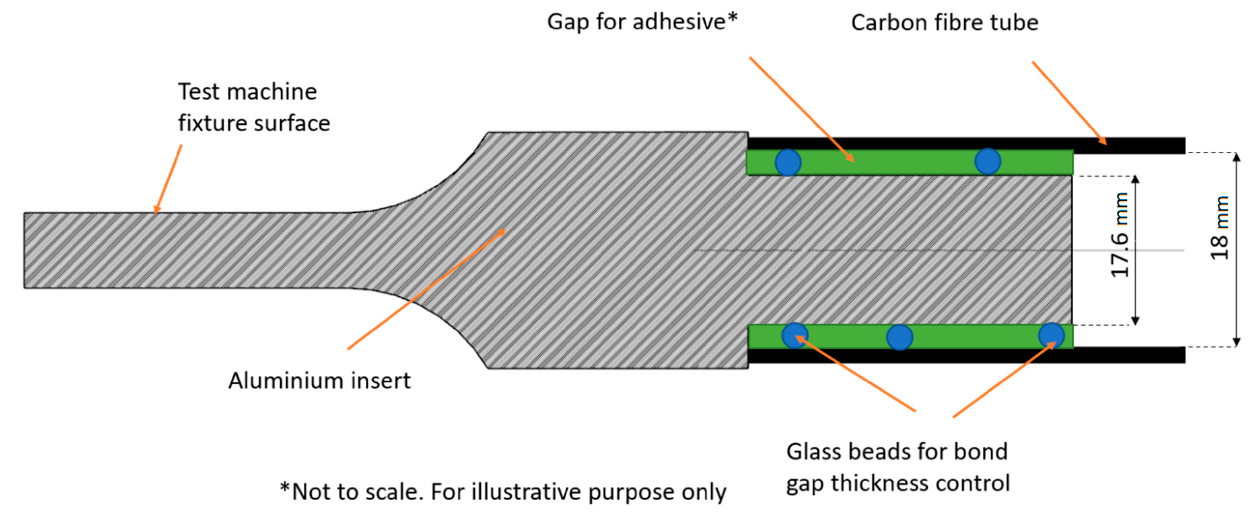
Figure 2. Idea of glass beads solution of bond gap thickness control.